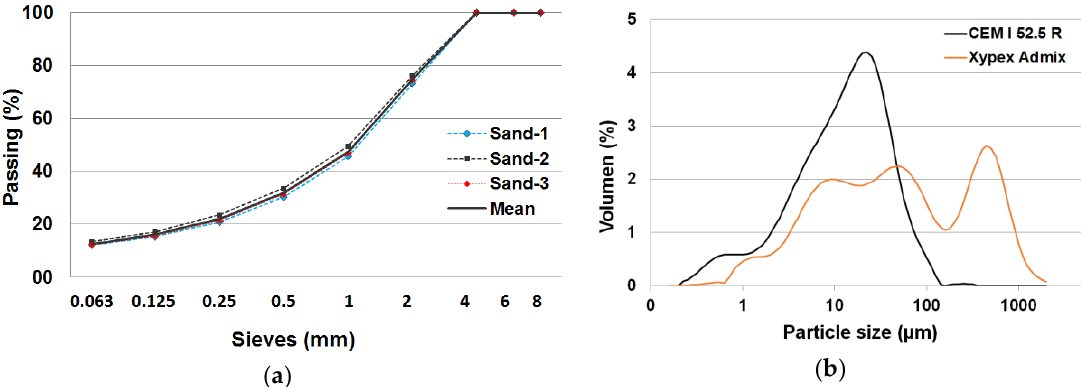
Figure 1. ( a ) Particle-size distribution of the limestone sand. ( b ) Particle-size distribution (done by laser granulometry) of the cement (CEM I 52.5 R) and the admixture (Xypex